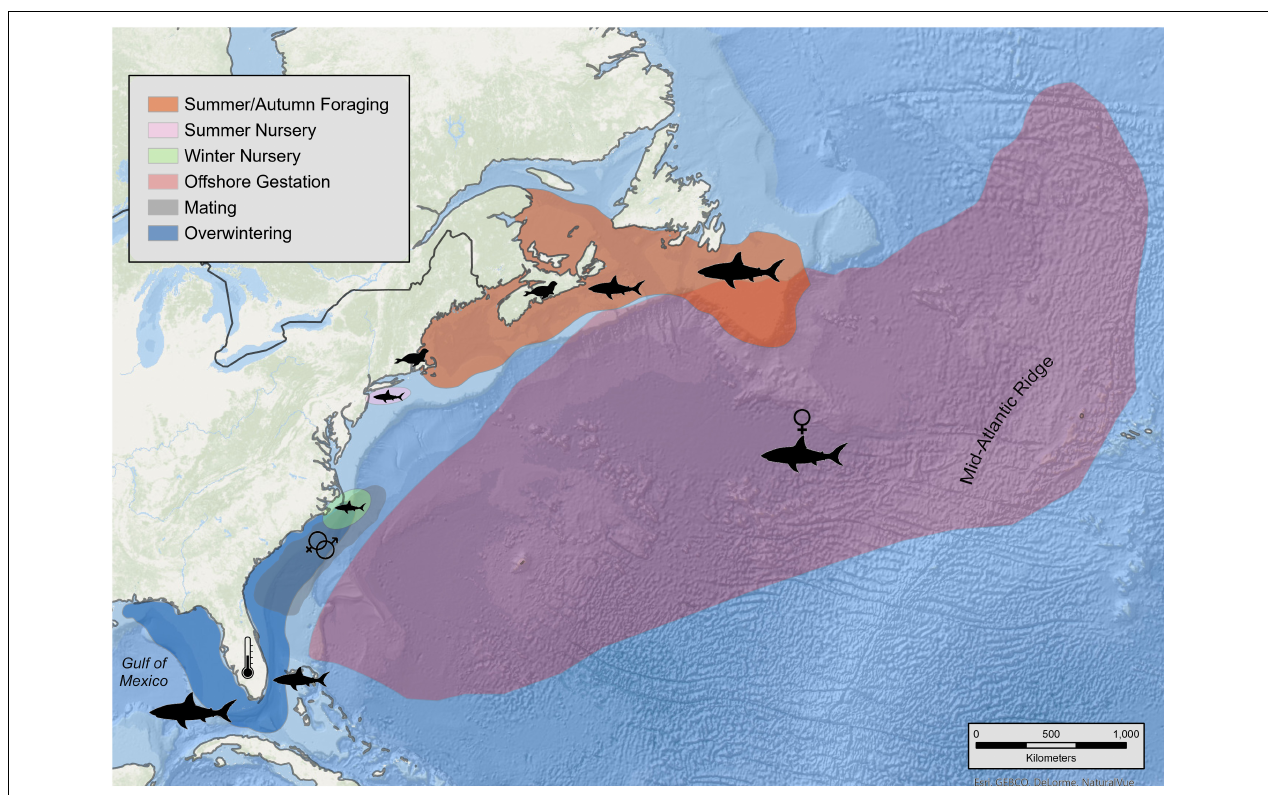
FIGURE 12 | Summary and conceptual framework for general movement patterns by white sharks in the western North Atlantic. Size of shark silhouette corresponds to broad age/size classes while seal silhouettes represent areas of known pinniped foraging areas by white sharks. Areas noted are based on a combination of previously published studies (Casey and Pratt, 1985; Curtis et al., 2014, 2018; Skomal et al., 2017; Gaube et al., 2018; Bastien et al., 2020; Shaw et al., 2021), data from this study, and proposed hypotheses for mating and gestation areas. Proposed mating area was derived from general locations of sharks during the late winter to early summer period of each year with the assumption of a ∼ 12–18 month gestation period, as well as anecdotal evidence of a large, female white shark observed with mating wounds off the shelf break of the Georgia coast in June of 2018. Proposed gestation area was derived from general locations of adult, female white sharks during these expansive offshore movement periods every 1–3